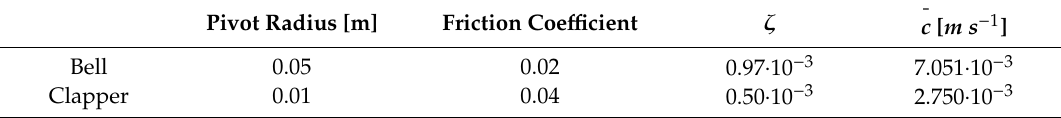
Table 9. Friction and 171 ◦ equivalent viscous damping parameters of St. Mary’s tenor